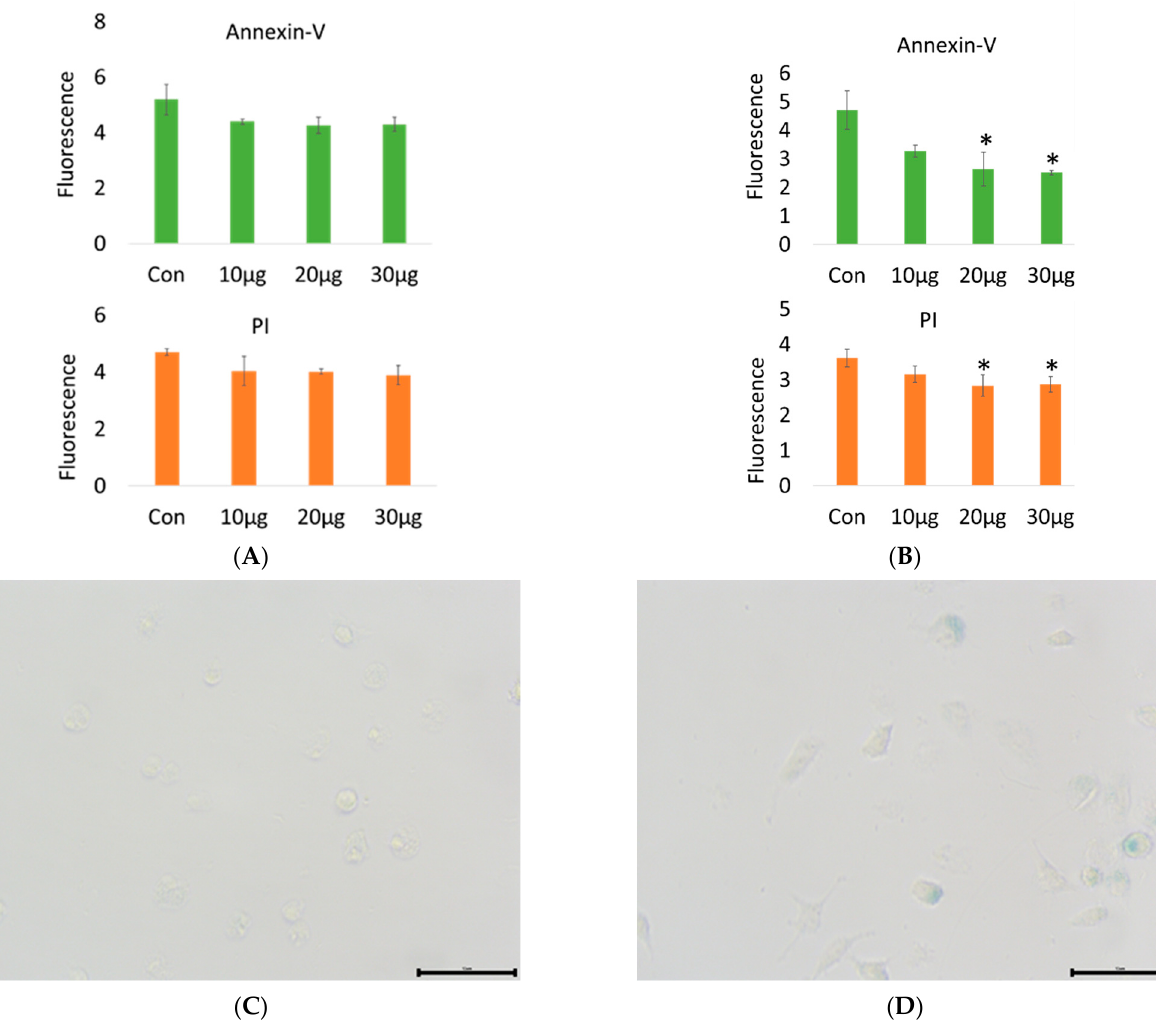
Figure 2. RAW 264.7 macrophage apoptosis detection via Annexin-V: ( A ) Treatment with 20 µ g/mL acetyl-xylogalactan was able to significantly reduce apoptosis ( p < 0.05) at 12 h under heat stress. ( B ) However, apoptosis did not show significant differences among groups at 24 h ( p > 0.05). ( C ) RAW 264.7 macrophage galactosidase detection at a normal temperature (37 ◦ C). ( D ) 30 µ g/mL acetyl- xylogalactan significantly induced galactosidase production (blue-stained cells) at 41 ◦ C (the black bar was shown as 50 µ m) ( p < 0.05 was marked as